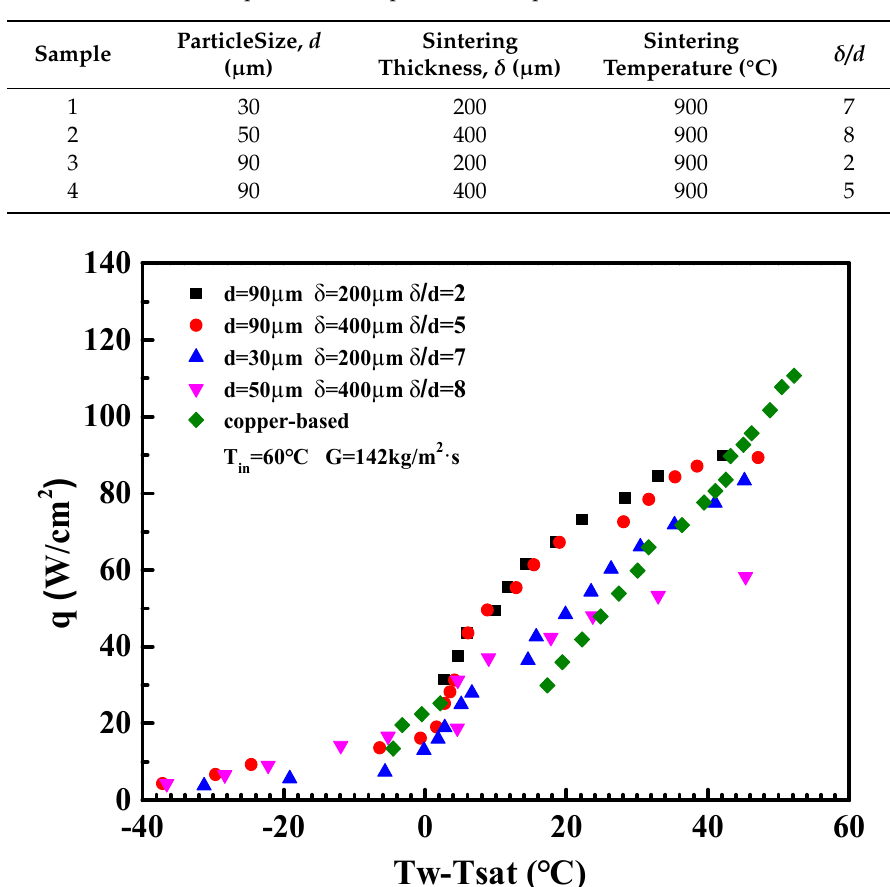
Table 3. Specification of parameters of porous microchannels.